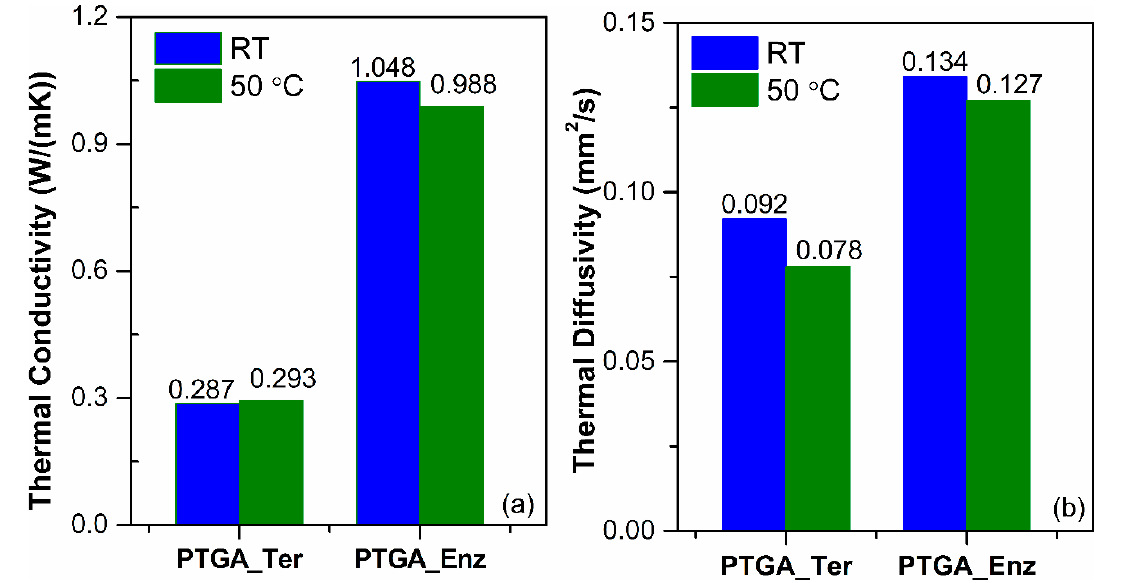
Figure 10. ( a ) Thermal conductivity results for PTGA_Enz and PTGA_Ter at room temperature (blue) and 50 °C (green). ( b ) Thermal diffusivity for PTGA_Enz and PTGA_Ter at RT (blue column) and 50 °C (green column). The values shown are the means of three independent measurements for each sample at each investigated temperature.